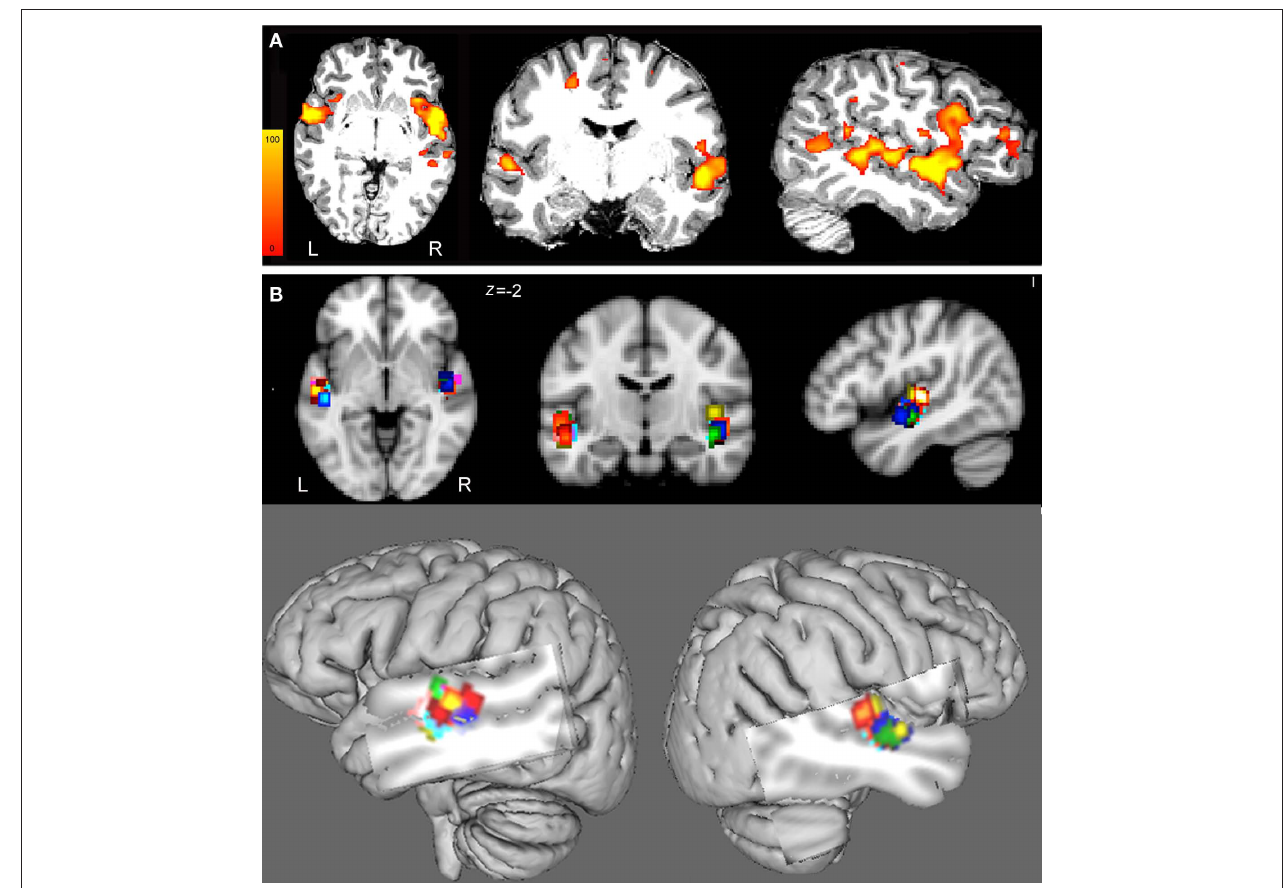
data displayed a target for the left HG at x = - 50, y = - 9, z = - 3 and for the right HG at x = 51, y = - 6, z = - 2 in MNI 152 space. These targets were used to guide the TMS coil positioning. (B) To enable group comparison, the individual regions of interest (ROI) were transformed in MNI152 standard space (see also Table 1 ). (Top) From left to right: axial, coronal, and sagittal views of the 5-mm-ROI for each subject and for left and right hemispheres (each color represents one participant). (Bottom) Overlay of the 5-mm-ROI for the left and right HG for all participants on a 3D